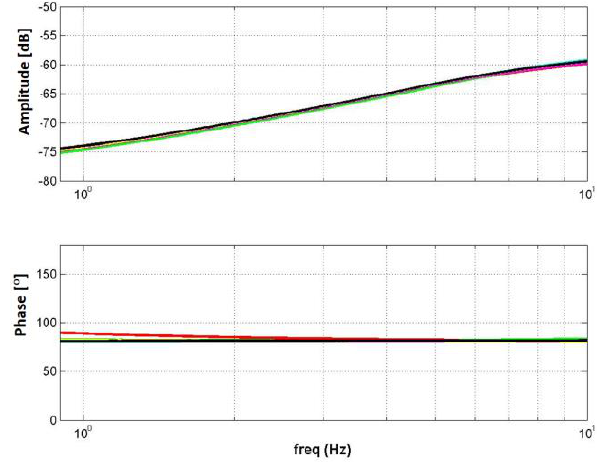
Figure 13. Bode plot of current as a function of input voltage amplitude and load.